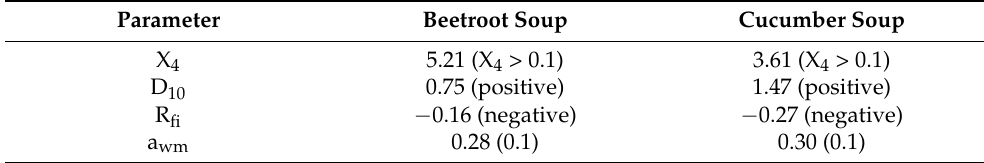
Table 9. Parameters of classification of sorption